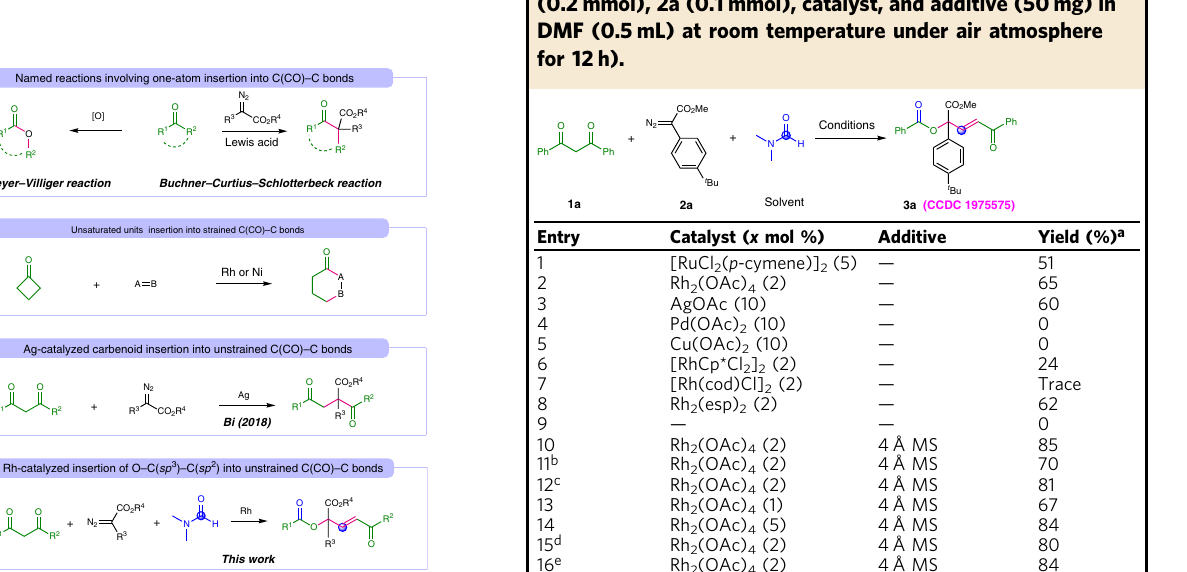
Table 1 Optimization of the transition metal-catalyzed C (CO) − C bonds insertion reaction (reaction conditions: